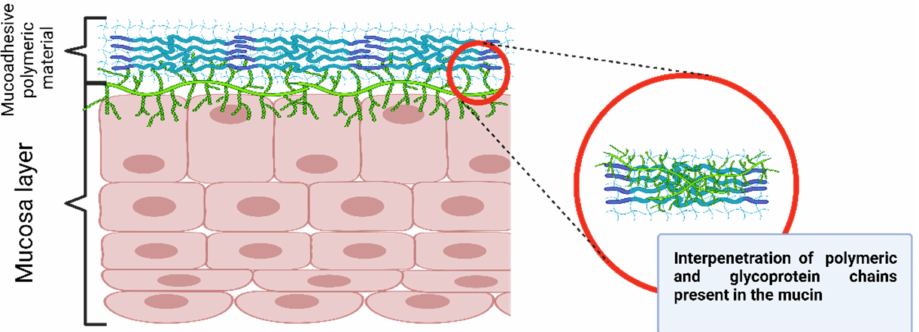
Figure 9. Diffusion theory mechanism. Created with